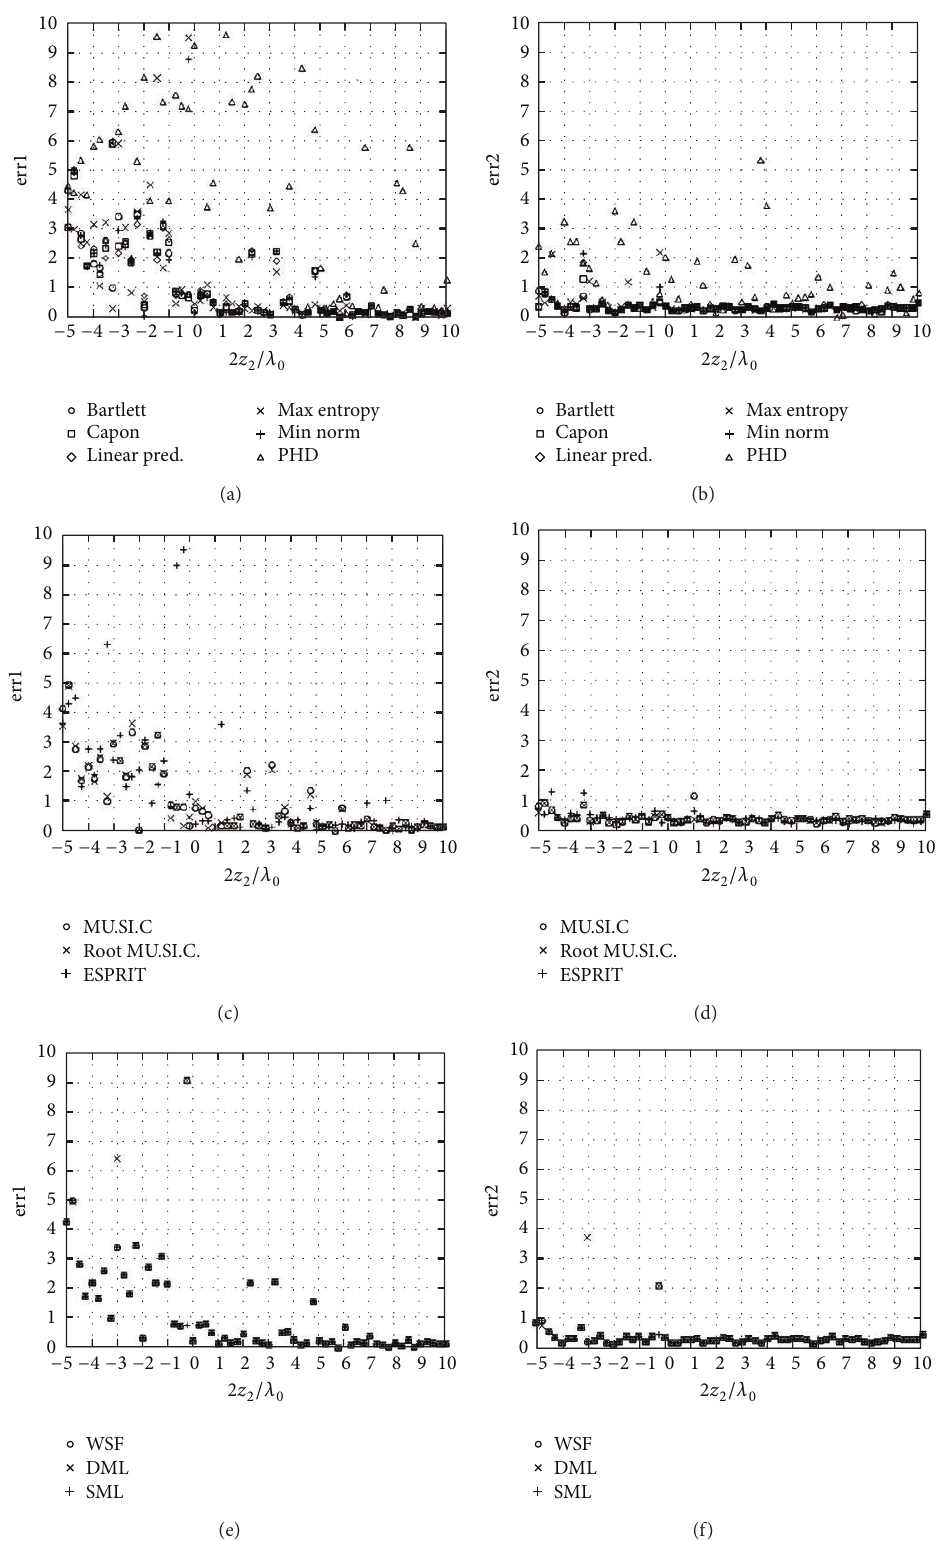
Figure 2: Localization of two perfectly conducting cylinders buried in a medium with 𝜀 𝑟 = 4 ; the position of the second cylinder is varied and the localization error is plotted. (a) Bartlett, Capon, Linear Prediction, Maximum Entropy, Minimum Norm and PHD estimation of the axis position for the first cylinder; (b) same as in (a), for the second cylinder; (c) MU.SI.C., root MU.SI.C., and ESPRIT estimation of the axis position for the first cylinder; (d) same as in (c), for the second cylinder; (e) WSF, DML, and SML estimation of the axis position for the first cylinder; (f) same as in (e), for the second